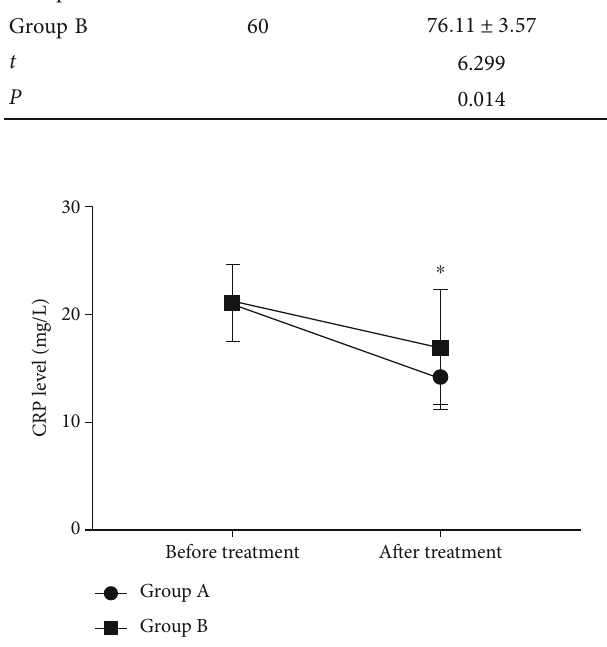
Figure 1: CRP levels of participants were compared ( − x ± s ,